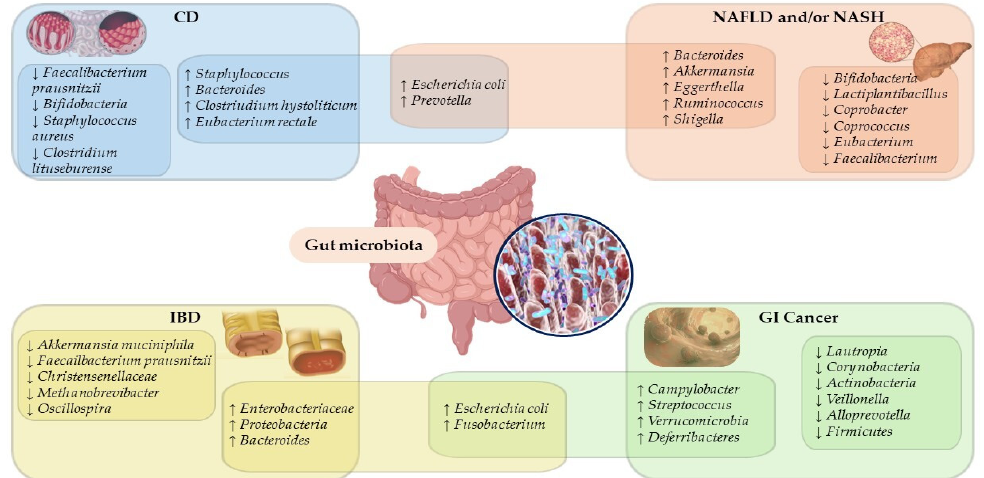
Figure 1. Overlapping microbiota species and genera signatures in gastrointestinal disease. Abbreviation: CD, celiac disease; GI, gastrointestinal; IBD, inflammatory bowel disease; NAFLD, non-alcoholic fatty liver disease; NASH, non-alcoholic steatohepatitis; ↓ , decrease; ↑ , increase.